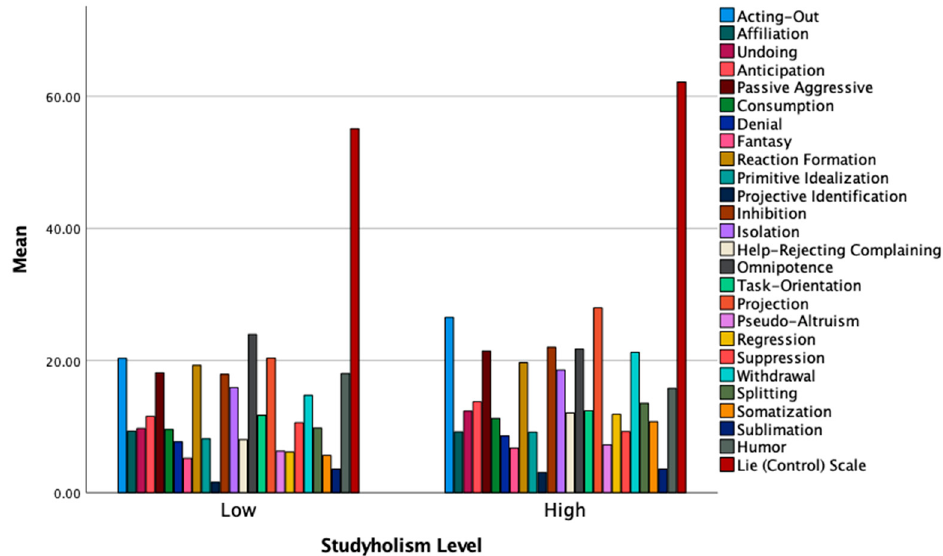
Figure 1. Mean levels of the defense mechanisms and the Lie scale by low and high Studyholism.